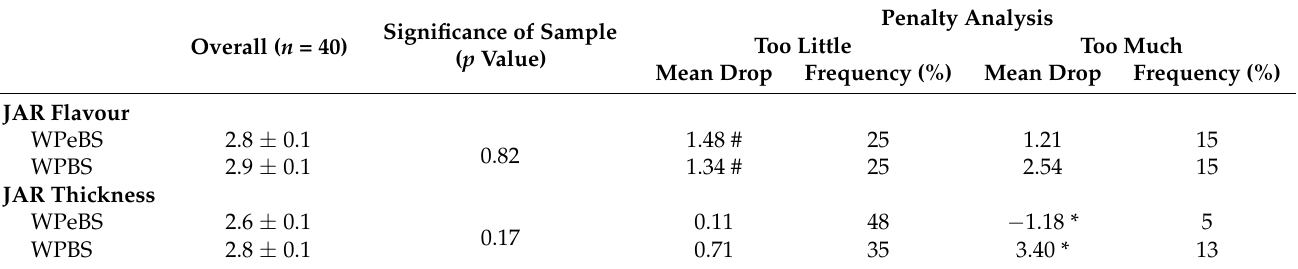
# represents a significant difference ( p < 0.05) within a sample in liking compared with mean liking rating, where the sample was considered Just-About-Right; * denotes size of the group lower than 20% of population. Frequency (%) is the % of volunteers within each group (too little or too much).